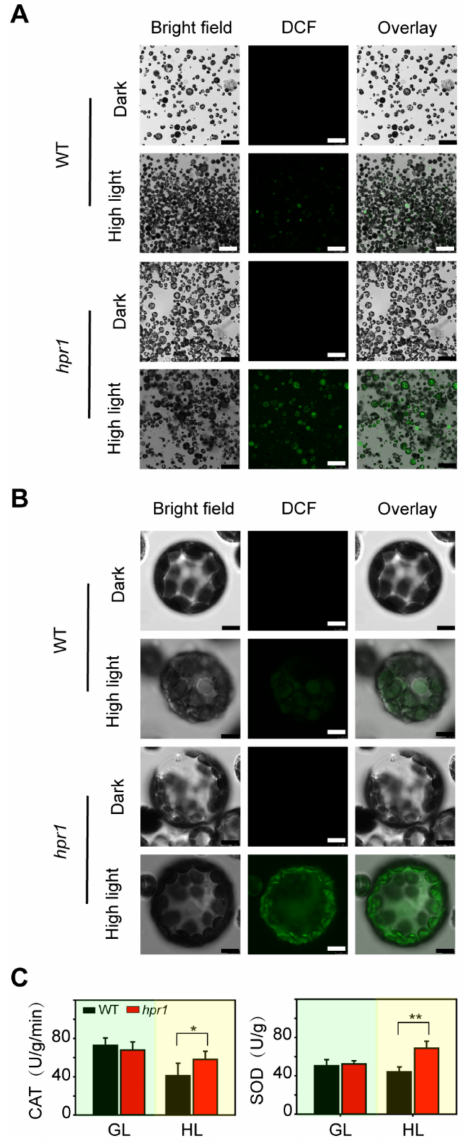
Figure 5. Detection of ROS production and removal. ( A , B ) Detection of ROS production. Protoplasts from WT and hpr1 mutants were treated with or without high light (1000 µ mol · m − 2 · s − 1 ) for 30 min, incubated with H 2 DCFDA (at a final concentration of 5 µ M), and observed using LCSM as described in the Materials and Methods. ( C ) Superoxide dismutase (SOD) and catalase (CAT) activities in WT and hpr1 grown under growth light (GL, 80 µ mol · m − 2 · s − 1 ) and high light (HL, 350 µ mol · m − 2 · s − 1 ). Values shown are means ± SD, n = 3, with three independent replicates. Asterisks show significant differences compared to WT: * p < 0.05; ** p < 0.01 (Student’s t